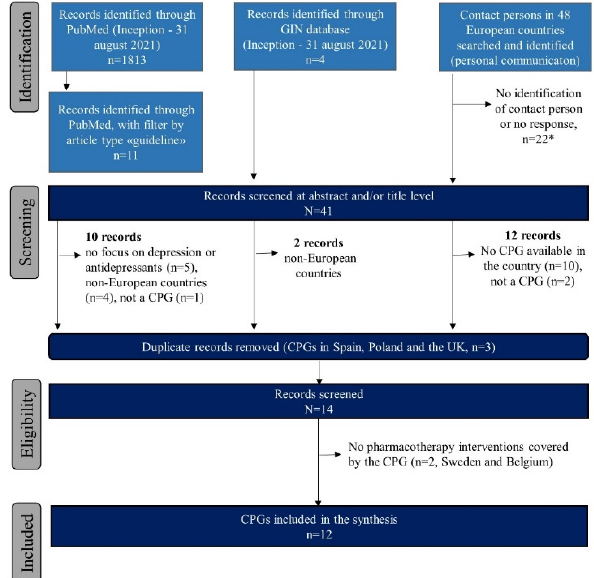
Figure 1. Flow chart of the review process for the clinical practice guideline synthesis. Abbreviations: CPG = clinical practice guideline; GIN = Guidelines International Network. * No response